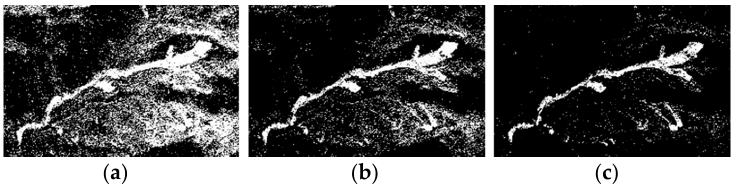
Figure 2. The difference images using single-threshold: ( a ) the threshold is 0.2, ( b ) the threshold is 0.3, and ( c ) the threshold is 0.4.